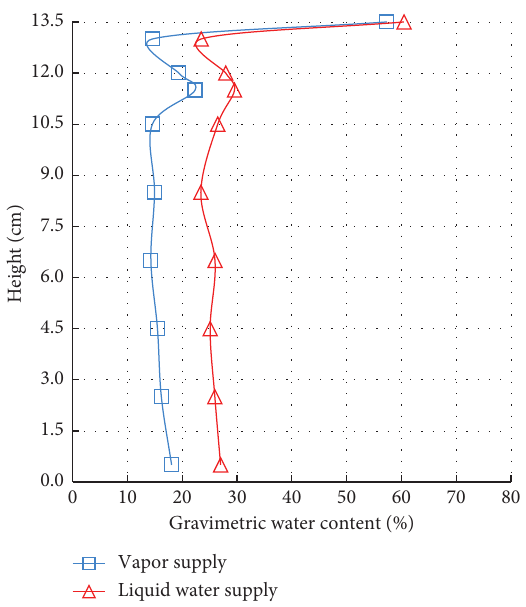
Figure 7: Water content distribution of different water supply